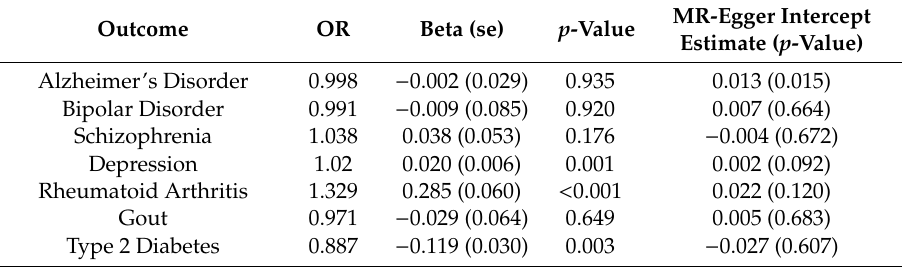
Table 3. Mendelian Randomization (MR) using variants from the SHBG Locus—Inverse Variance Weighted (IVW)